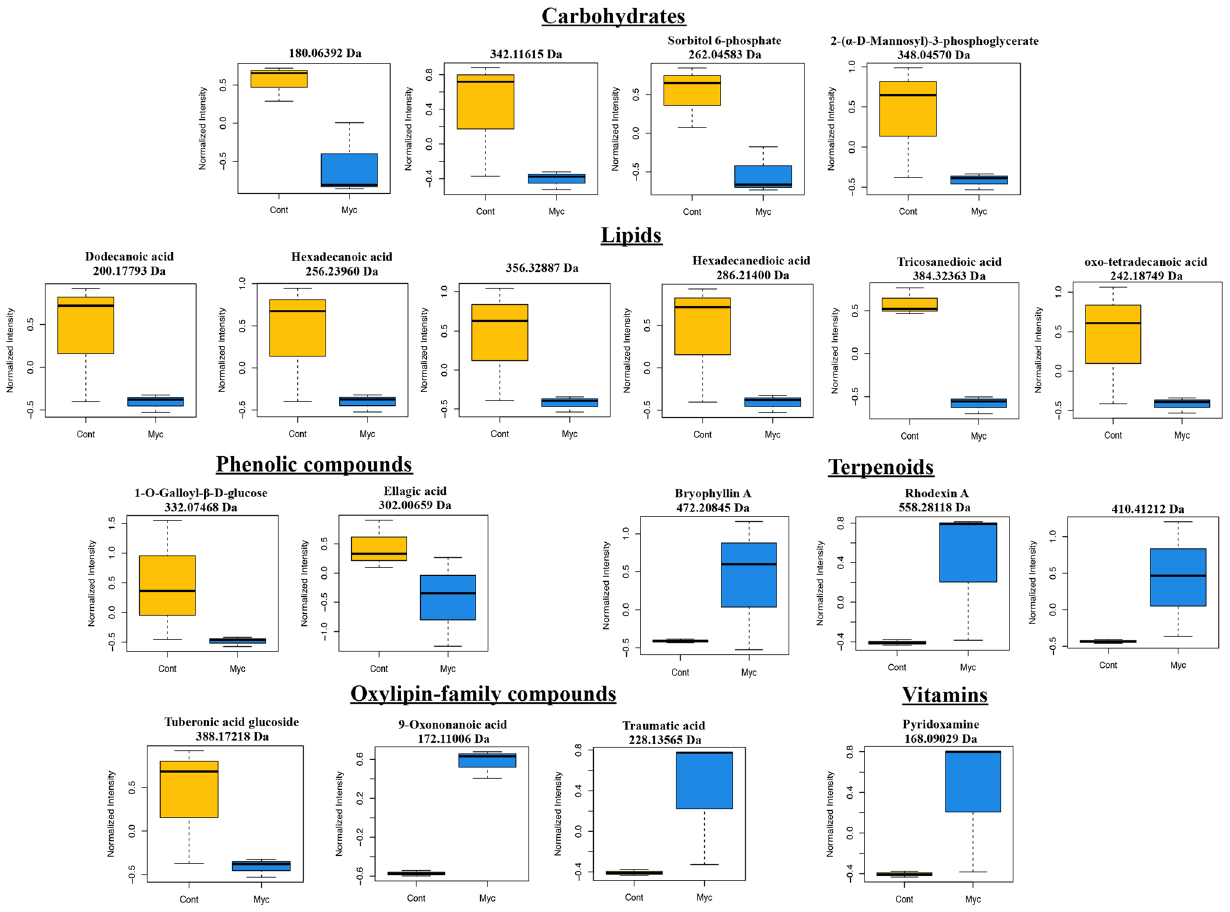
Figure 6. Accumulation profile of selected metabolites (VIP > 1) in cork oak mycorrhizal roots. P. tinctorius inoculated roots (Myc) and non-inoculated roots (Cont) were used for relative quantification by FT-ICR analysis. Compounds only tentatively identified are identified by an m/z ratio. Charts were produced with the free available on-line software RStudio v1.2.5042 83